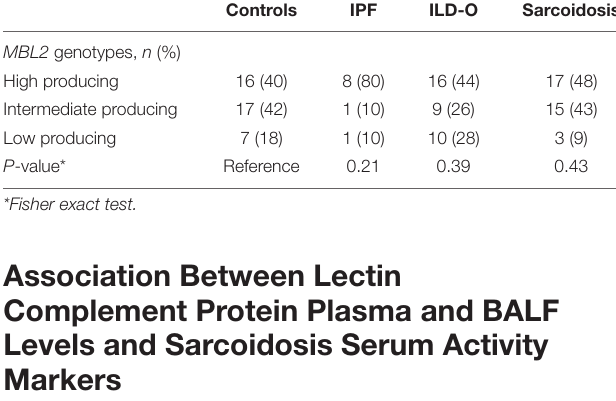
TABLE 4 | Distribution of MBL2 genotypes in cases and controls. Controls IPF ILD-O